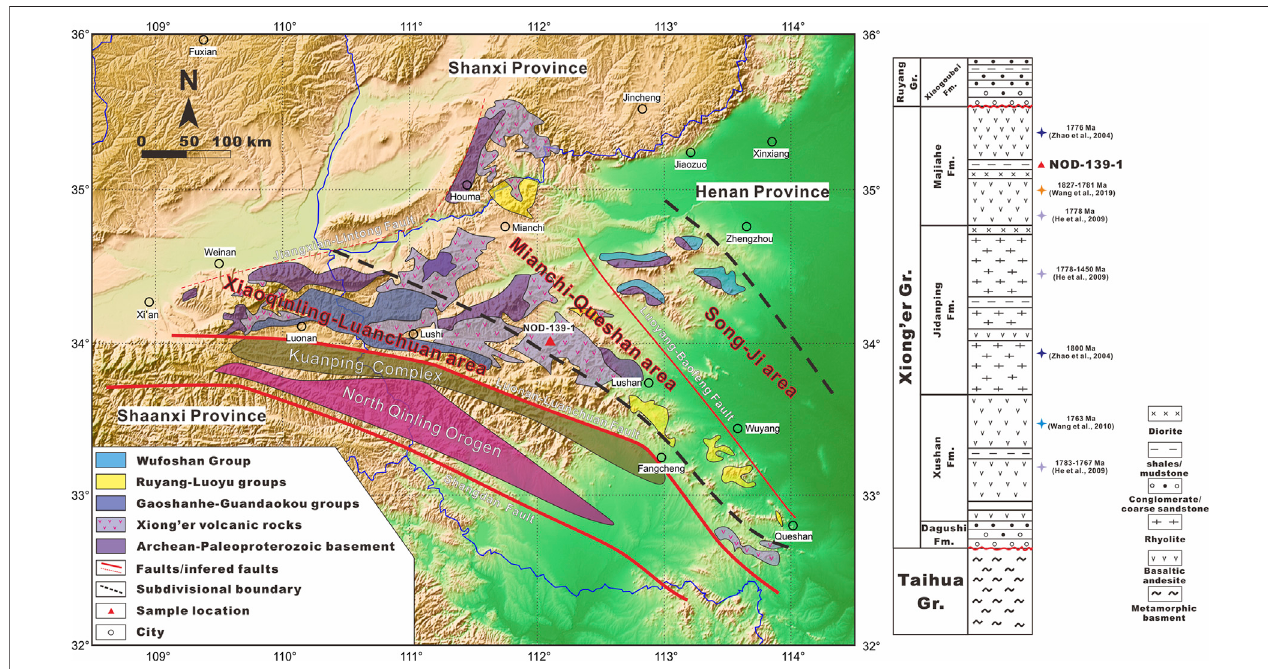
FIGURE 1 | The distribution of the Xiong ’ er Group and the sample